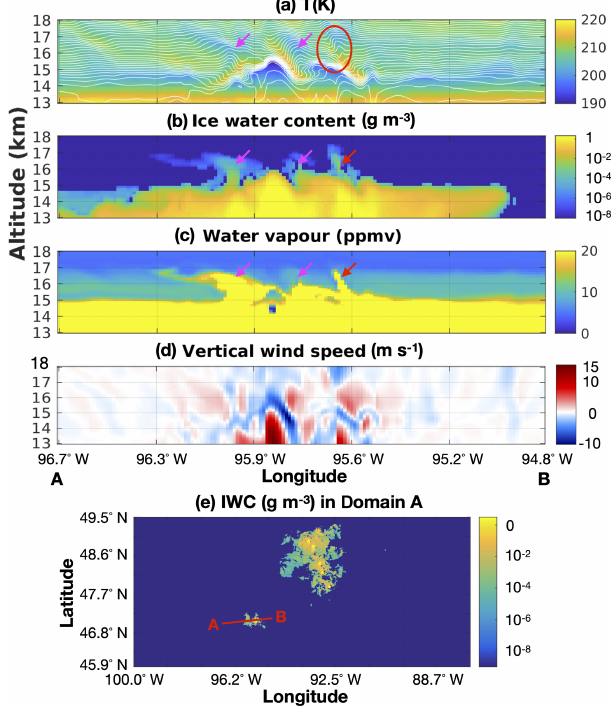
Figure 4. GEM-simulated overshooting convection. The results il- lustrated here are taken from the 1km simulation at 19:46UTC, 25 August 2013: (a) temperature (colour) and potential temperature (thin white lines); (b) ice water content, in logarithmic scale; (c) wa- ter vapour mixing ratio, in ppmv; (d) vertical wind speed, in ms − 1 ; and (e) ice water content in Domain A at the level of 15.24km at 19:46UTC on 25 August from the 1.0km simulation. The red line shows the location of cross section